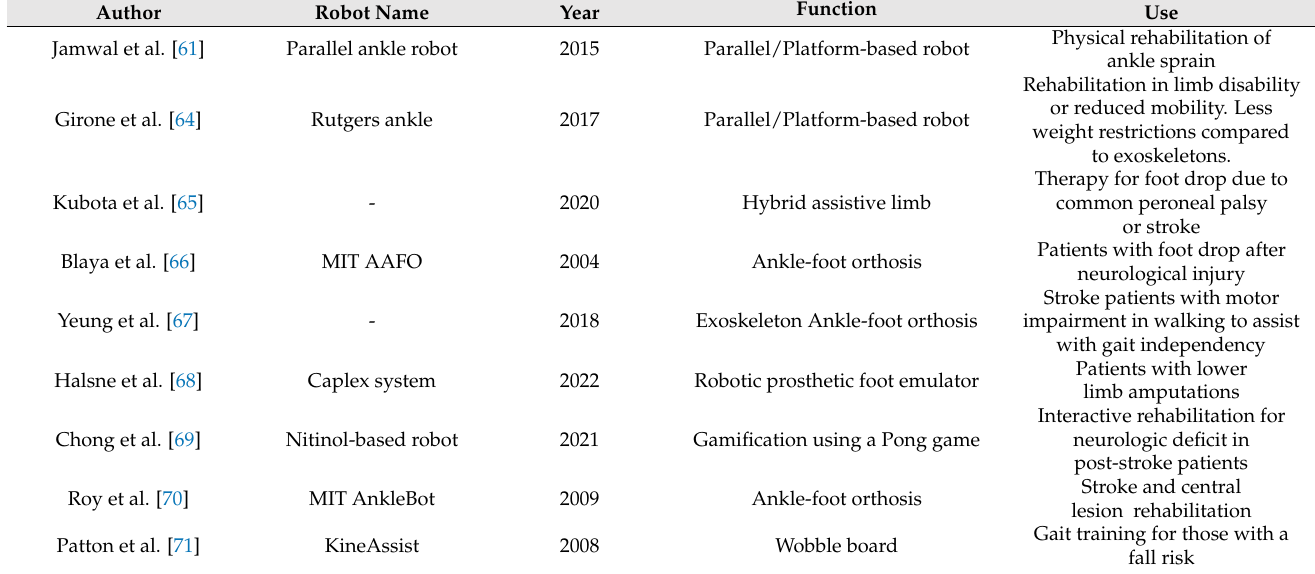
Table 3. Rehabilitational device applications in foot and ankle